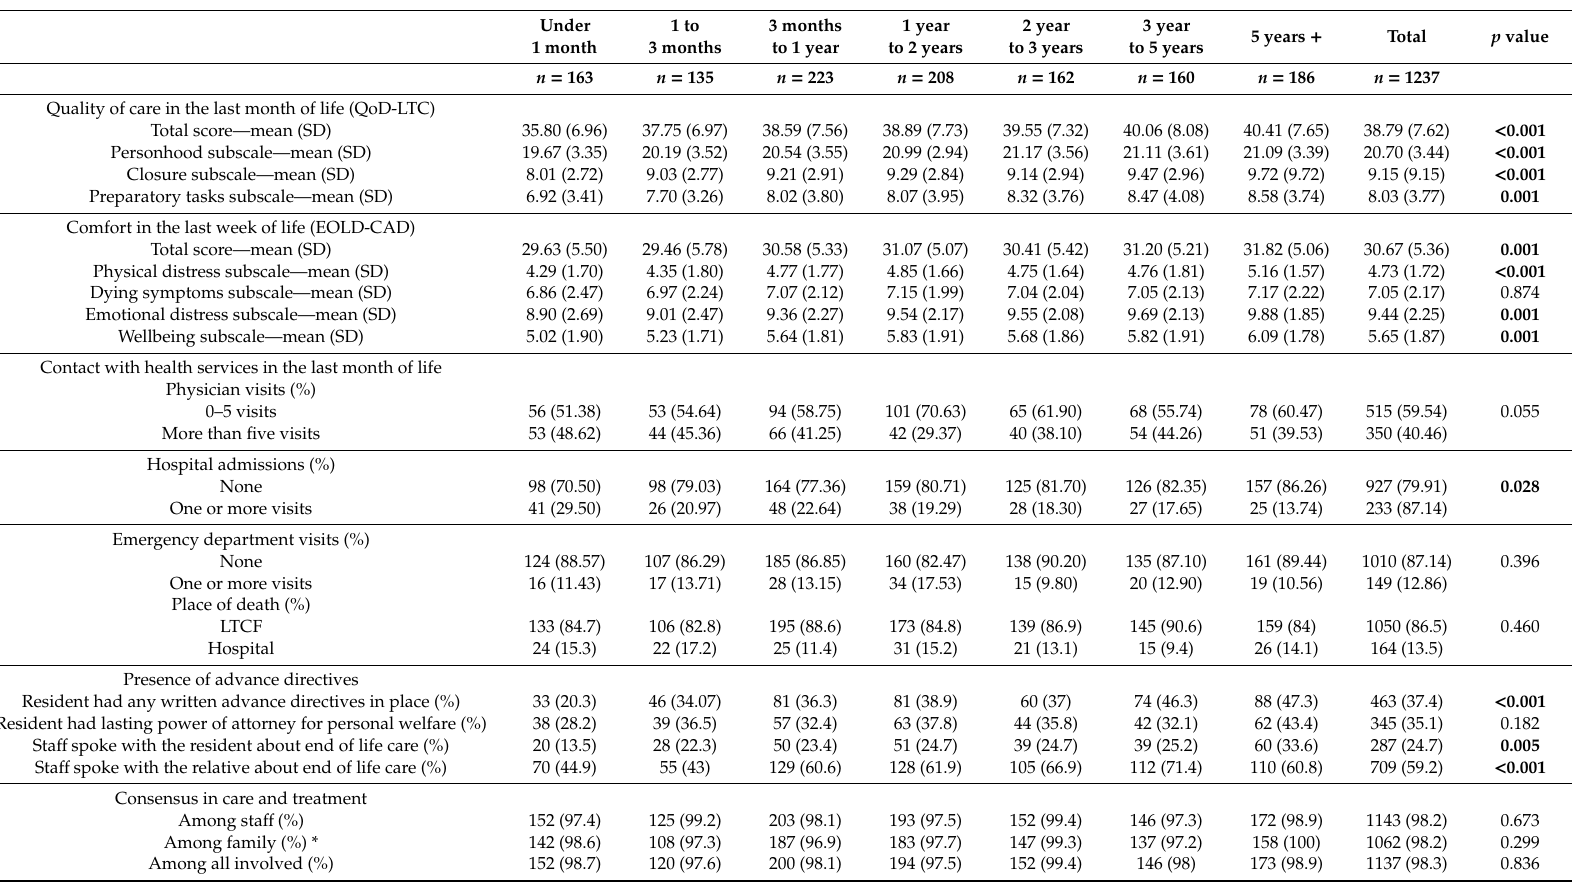
Table 2. Indicators of end of life care of deceased LTCF residents by length of stay in a LTCF until death. Under 1 month Quality of care in the last month of life (QoD-LTC) Total score—mean